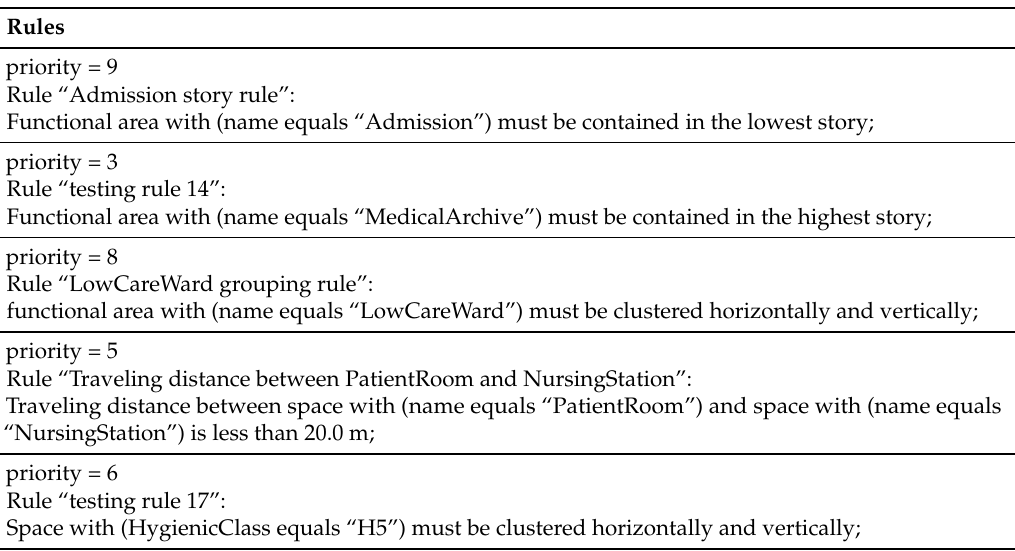
Table 4. Example of rules implemented in the